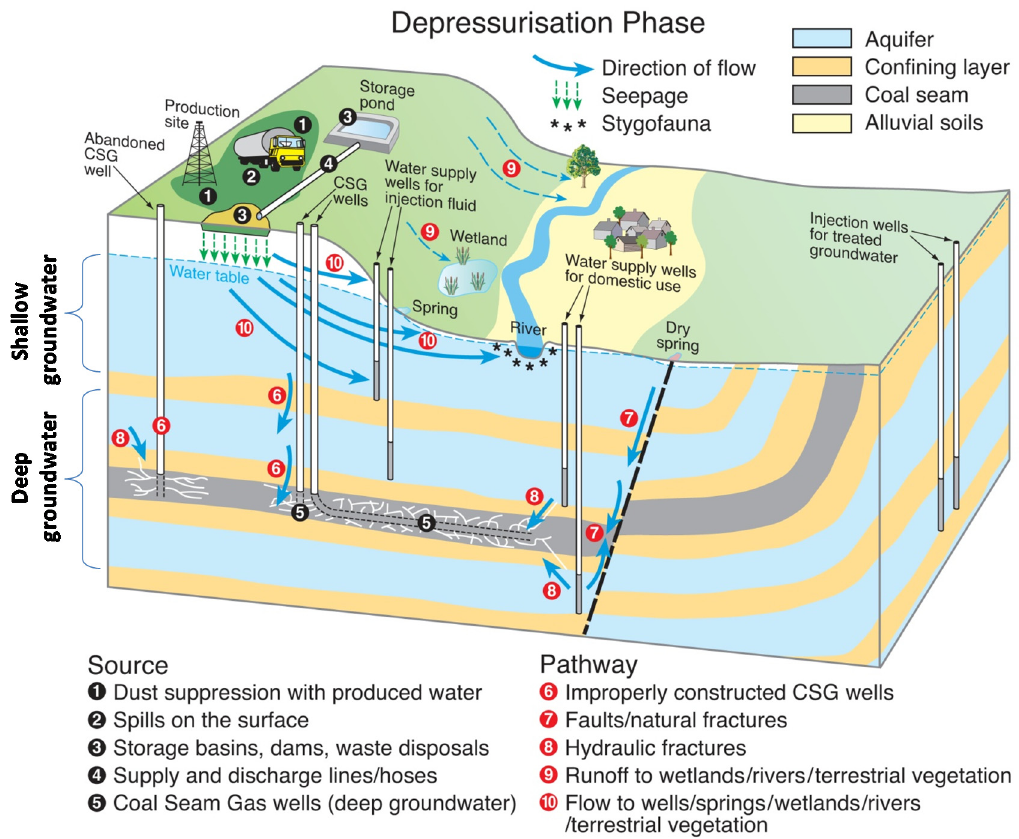
Figure 1. Possible contaminant sources at the coal seam gas site (1 to 5), migration pathways in shallow (10) and deep (6 to 8) groundwater, and via surface runoff (9) during the depressurization phase. Source: [27].